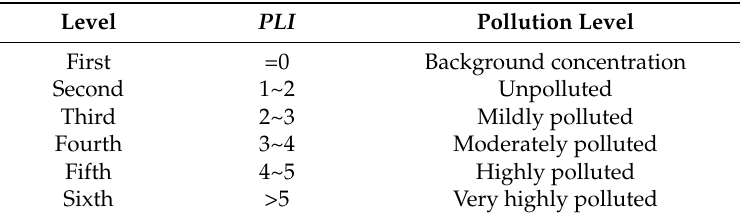
Table 2. The standard of pollution load index.